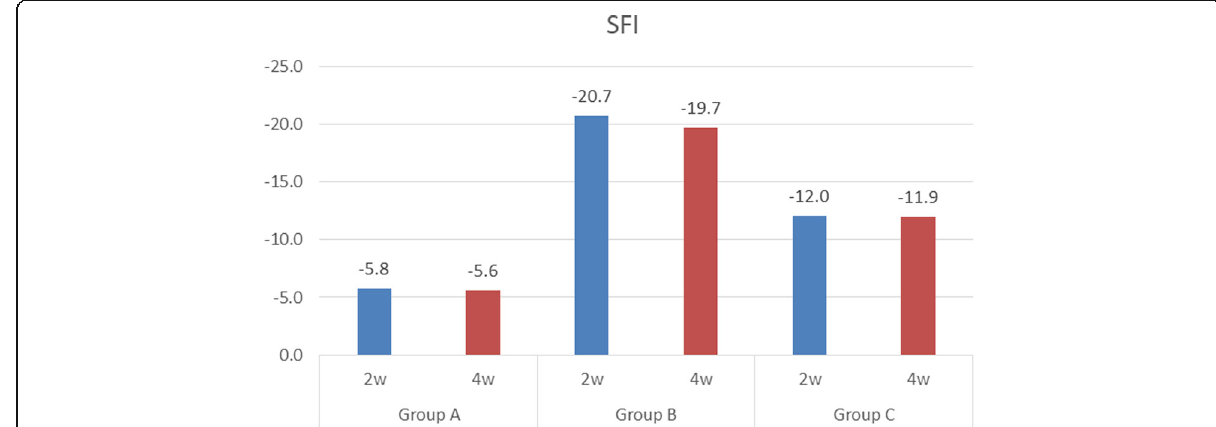
Fig. 7 The mean value of the sciatic functional index in the three groups